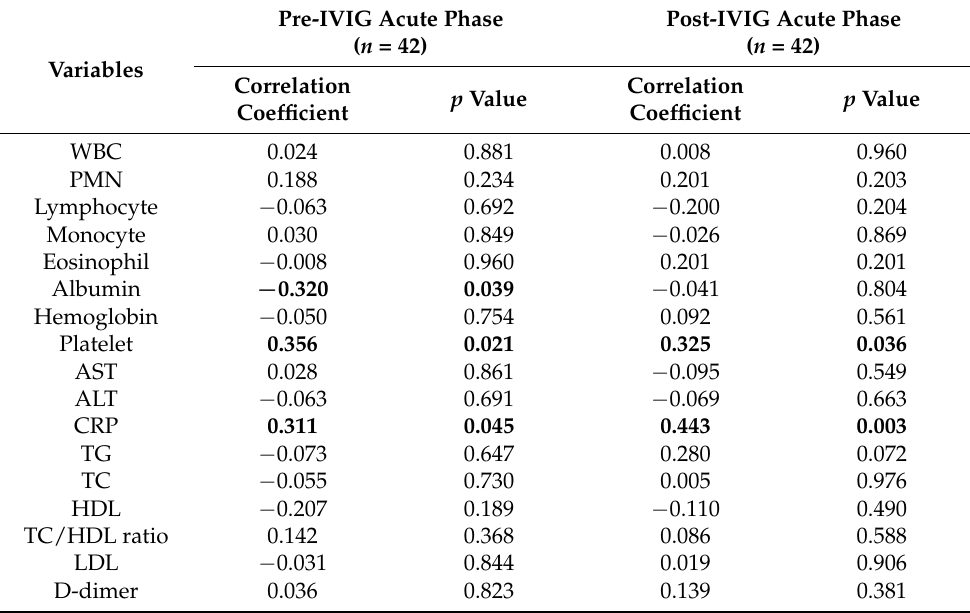
Table 2. The correlation between VEGF and laboratory data of KD patients in the acute pre-IVIG and post-IVIG phases.